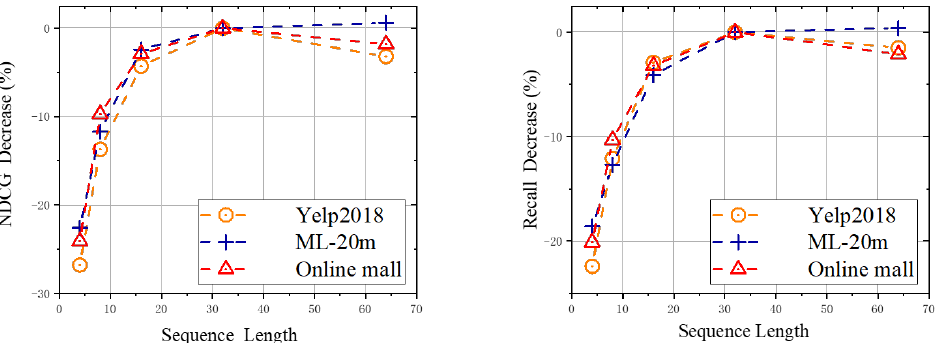
Figure 4. Performance comparison of methods with different behavior sequence lengths, N, on three datasets.